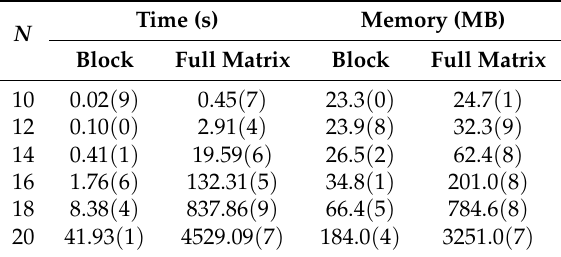
Table 3. Computation times and memory usage of time evolution of the SIS agent-based epidemic models (ABEM) for various population sizes, with (block) and without (full matrix) cyclic